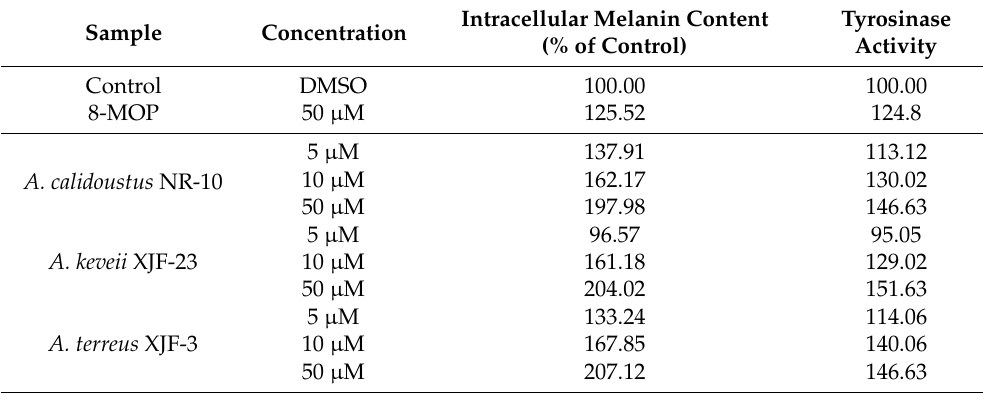
Table 5. Effect of crude extracts of endophytic fungi on melanin production and tyrosinase activity in B16 cells.